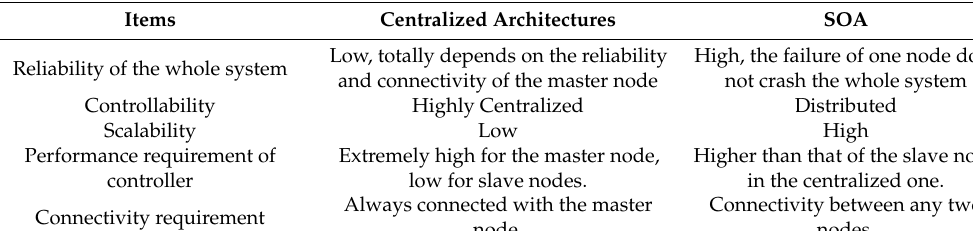
Table 2. Comparison of centralized architectures and SOA for ocean observatories.